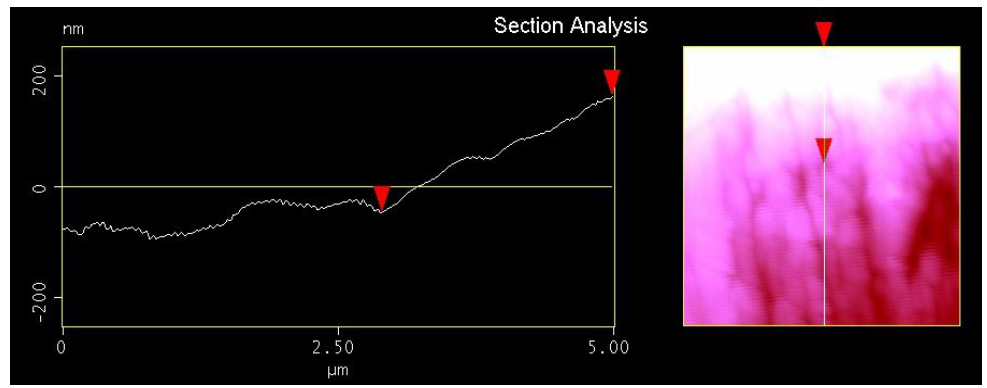
Figure 6. A sample of the profile of indentation plane that was used to determine the sample tilt. The AFM images of the indented region of the aluminum sample before and after the indentation in one of the tests are shown in Figure 7.